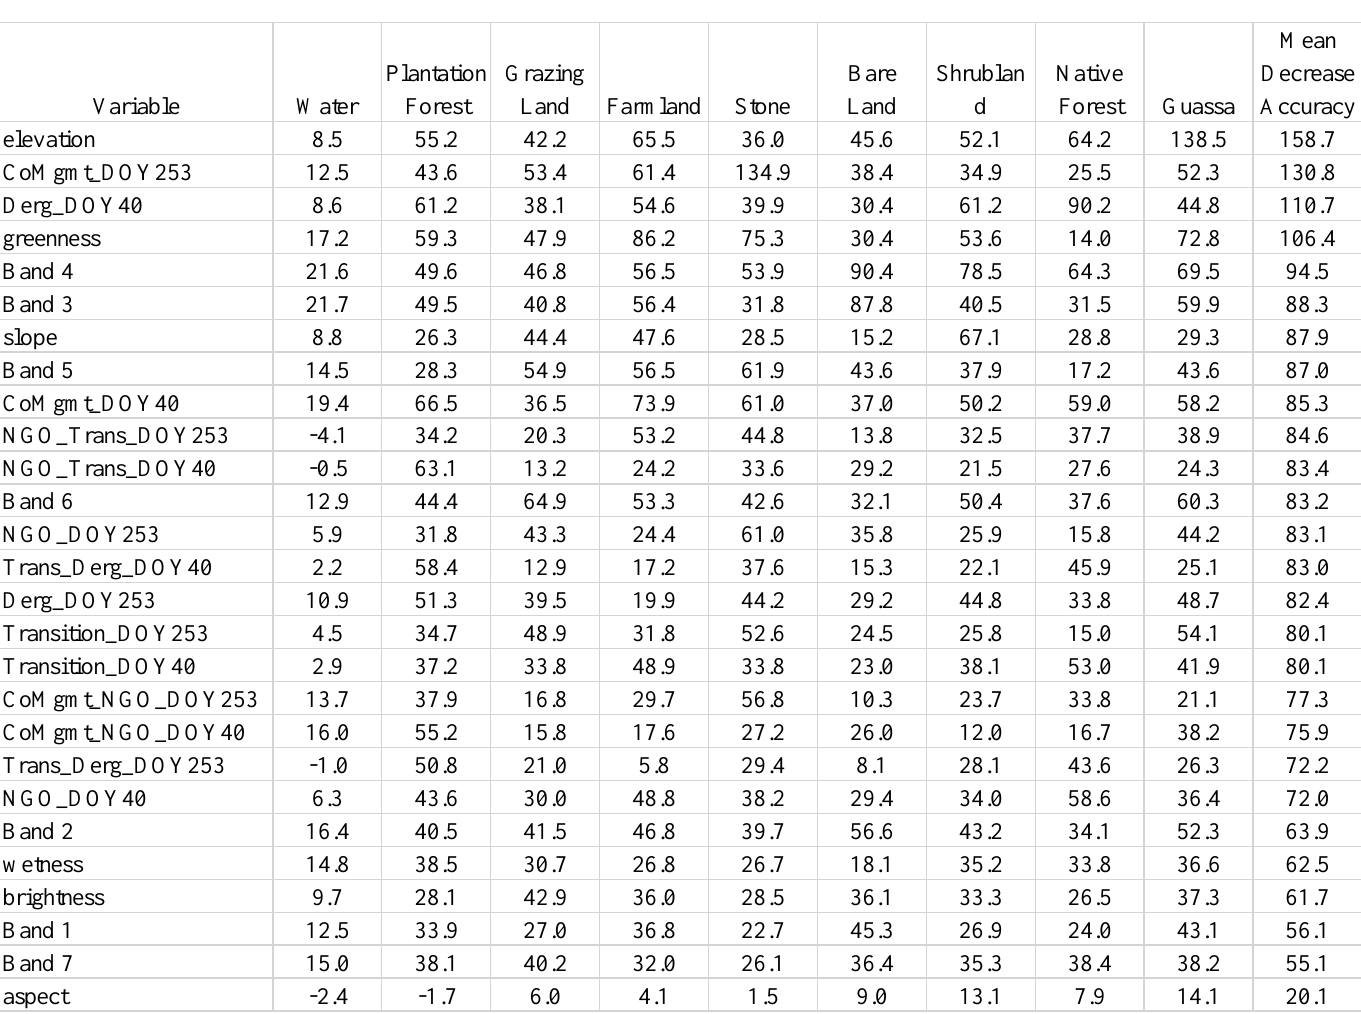
Table A1.5 . Relative variable importance (calculated by mean decrease in accuracy) for each predictor variable. Variables are presented in mean decreasing importance across all land